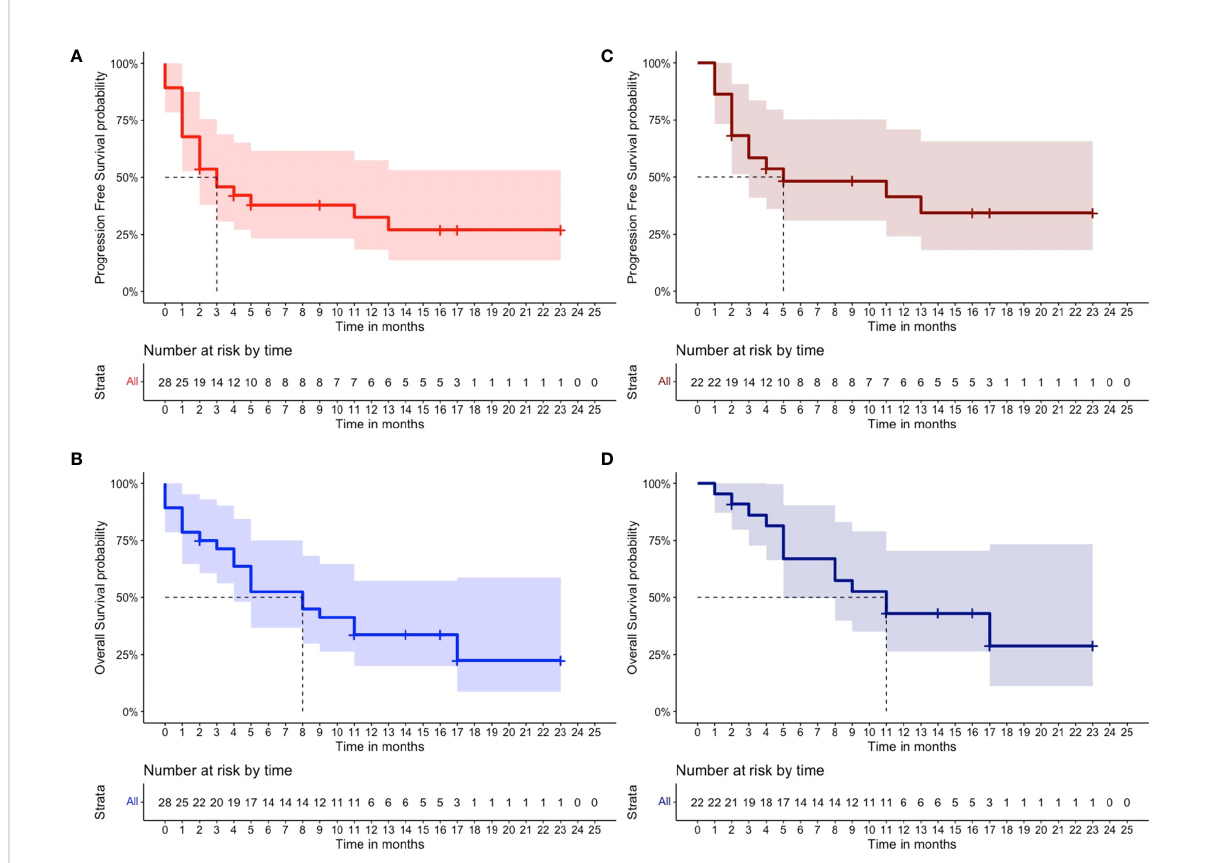
FIGURE 1 Clinical outcomes of patients receiving belantamab-mafodotin. (A) Progression-free survival and (B) overall survival of multi-refractory/relapsed multiple myeloma patients of total cohort (N = 28) who received belantamab-mafodotin, and (C) progression-free survival and (D) overall survival of multirefractory/relapsed multiple myeloma patients of the evaluable cohort (N = 22) who received at least two belantamab-mafodotin administrations are shown. The number of censored subjects at risk is also